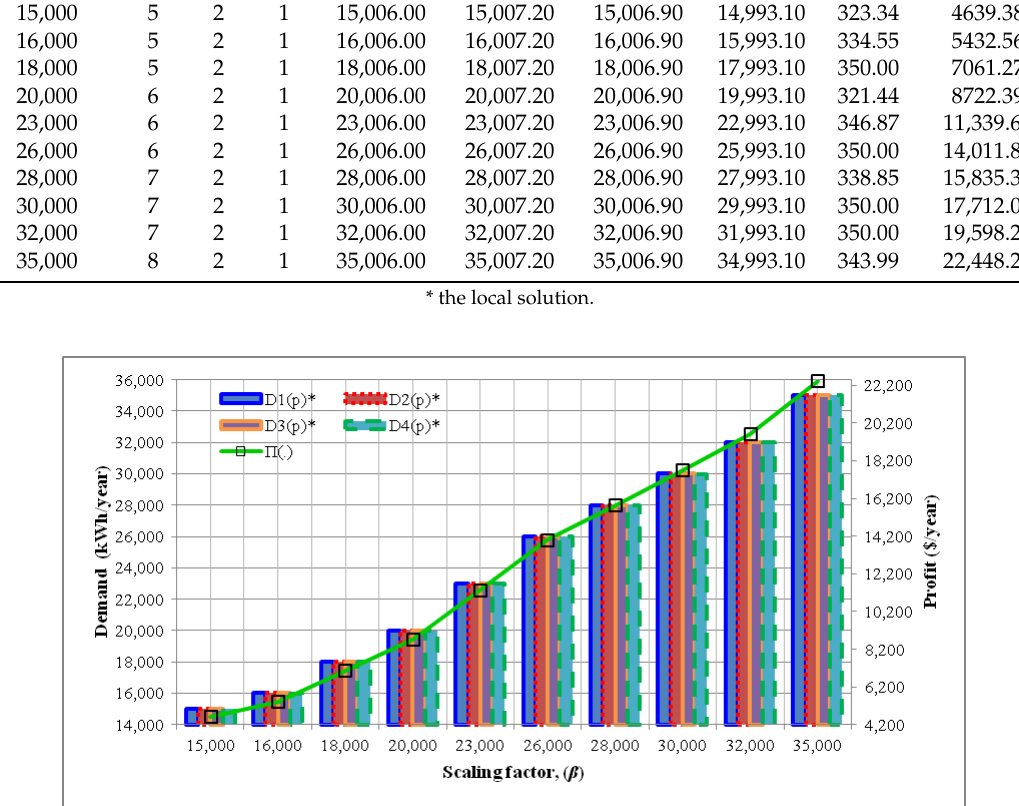
Figure 3. The Effect of Changes in the Scaling Factor on Profitand Demand.